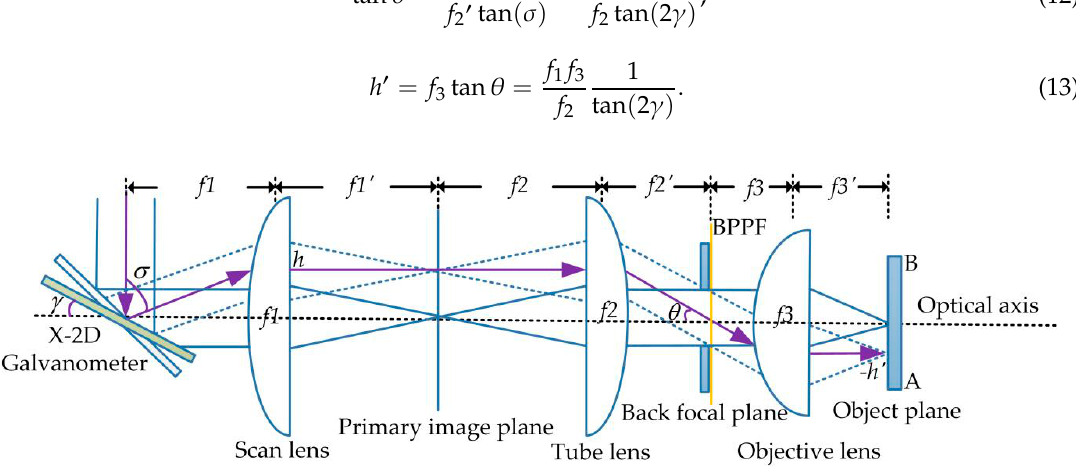
Figure 6. The schematic of the geometric optical path.